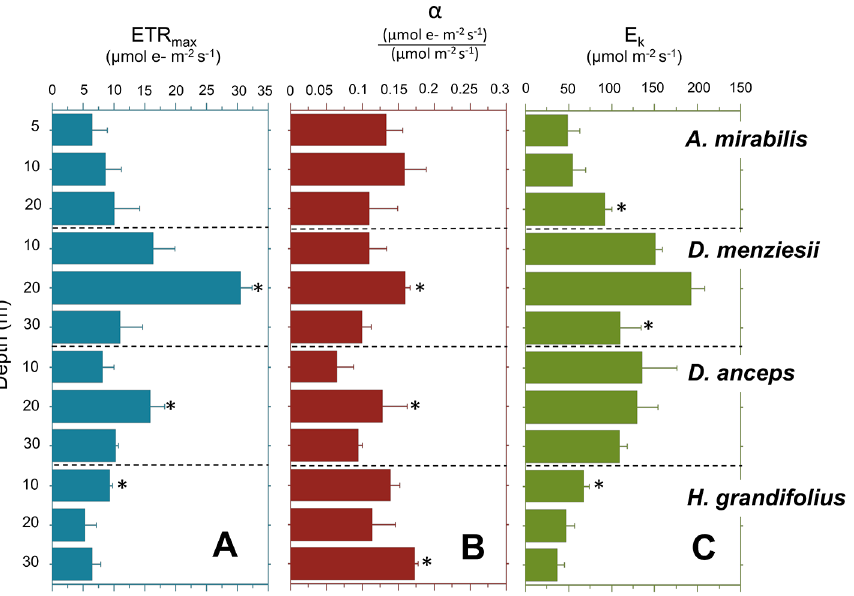
Fig 3. Variation in photosynthetic parameters (A) ETR max , (B) initial slope and (C) E k calculated from electron transport rate based P – E curves of four Antarctic brown collected from three different depths at Fildes Bay. Values are means ± S.D., n = 4. Asterisks indicate significant difference (p < 0.05) after ANOVA and Tukey HSD post-hoc